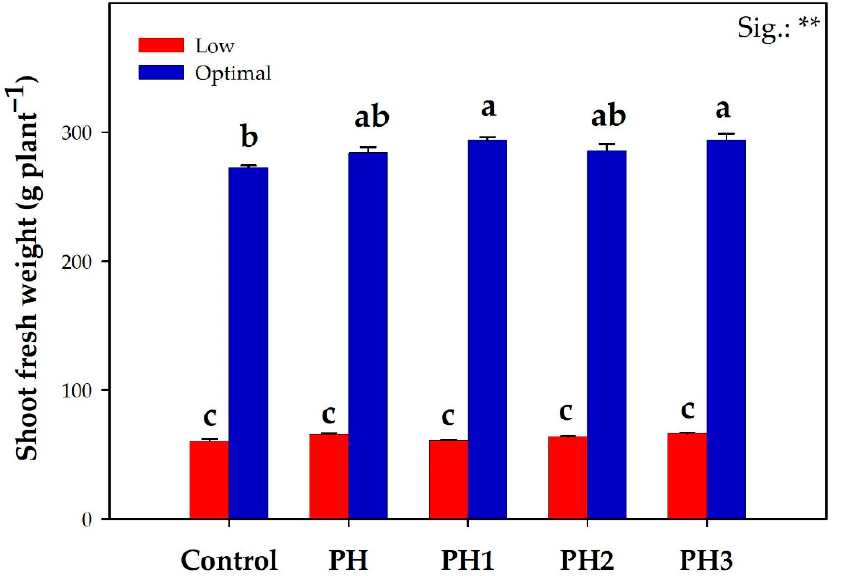
Figure 1. The commercial yield of lettuce plants as affected by nitrogen dosage and biostimulant application. All data are expressed as mean ± standard error, n = 3. Interaction data were deemed significant at p ≤ 0.01 (**). Different letters above the bars indicate significant differences according to Tukey’s HSD test, performed at p ≤ 0.05. PH: protein hydrolysate, molecular fractions PH1, PH2 and PH3 (>10 kDa, between 1 and 10 kDa, <10 kDa). Nitrogen dosage: Optimal = 8 mM NO3, Low = 1 mM NO3.